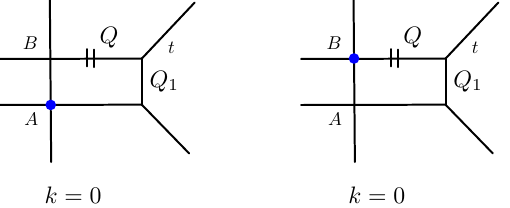
Figure 9 . The bare CS level for this web is zero. The assignment of refined parameter t is shown in brane webs. The short double line || is a notation in topological vertex method, denoting that the preferred direction is along horizontal